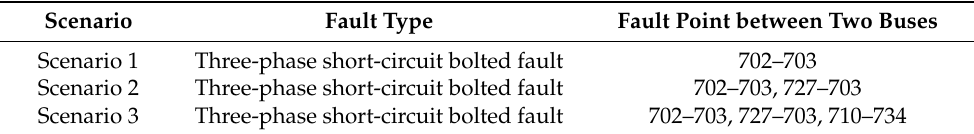
Table 2. Fault point assumption of each scenario.